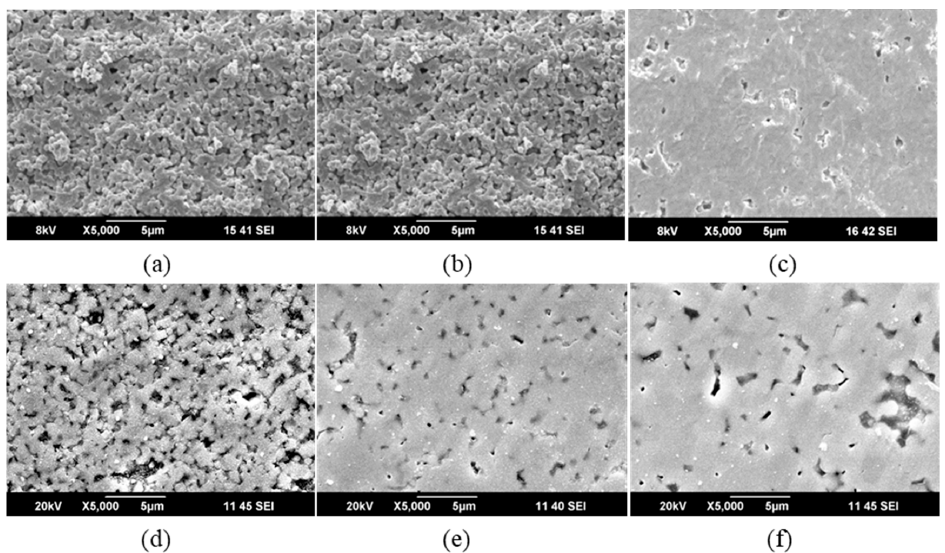
Figure 7. SEM images of fractured BaTiO 3 ceramics ( a – c ) and their polished surfaces ( d – f ) after the sintering at 1225 °C: ( a ) and ( d )—without Bi 2 O 3 addition; ( b ) and ( e )—modified with 0.1 mol % Bi 2 O 3 ; ( c ) and ( f )—modified with 0.5 mol % Bi 2 O 3 .